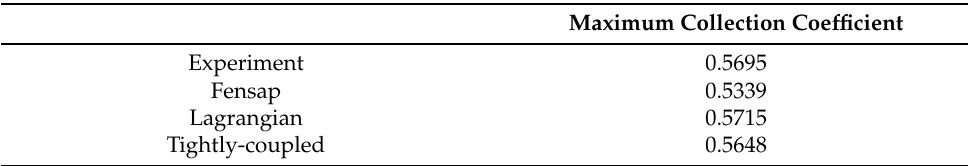
Table 2. The maximum collection coefficient.